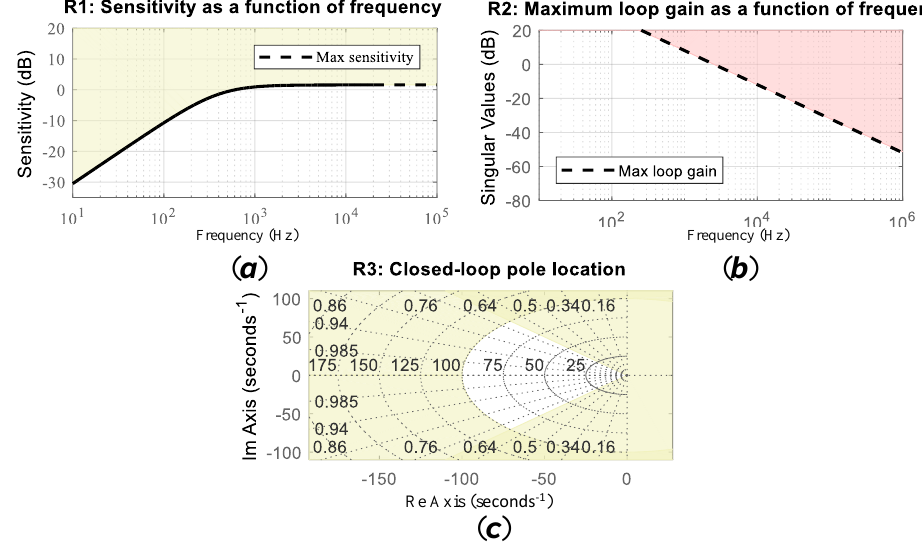
Figure 5. Closed-loop specifications for the structured H ∞ PI structured controllers: ( a ) R 1 sensitivity function, ( b ) R 2 maximum loop gain, and ( c ) R 3 minimum damping and maximum natural frequency for the closed-loop poles.